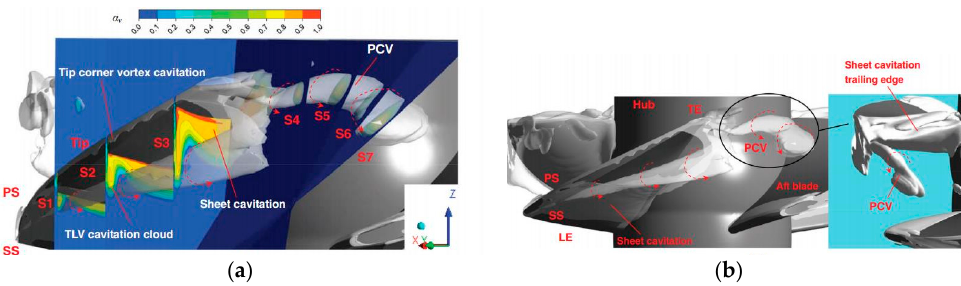
Figure 20. Isosurface of α v = 0.1, contoured by vapor volume fraction in an axial pump at cavitation number σ = 0.262 [44]. ( a ) Vapor volume fraction contours; ( b ) TLV cavitation cloud. S1–S7: symbols of cross sections; α v : vapor volume fraction. PCV: perpendicular cavitation vortex.